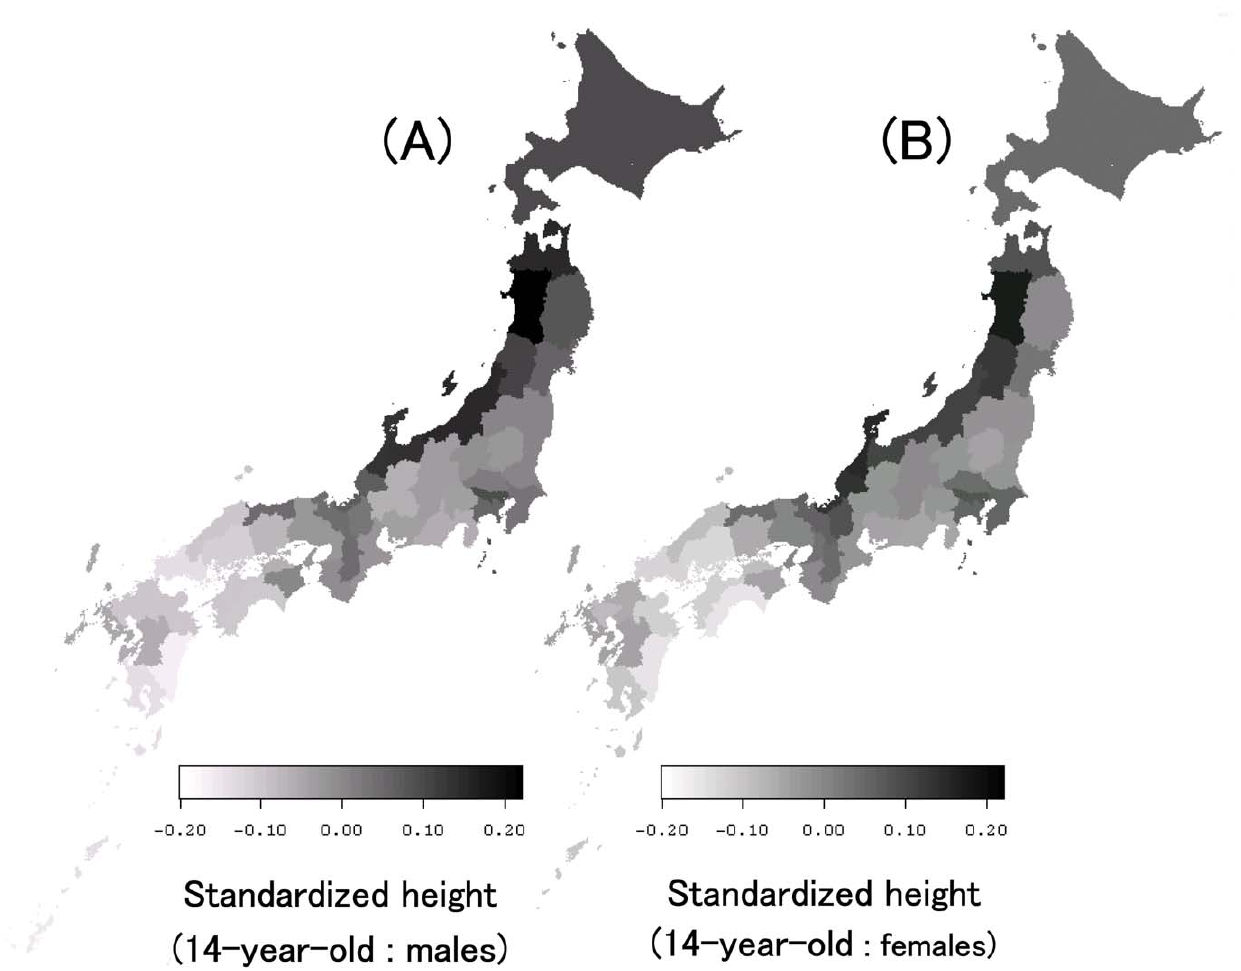
Figure 2. Distribution map of standardized height of Japanese youth. Distribution map of 13-year (1996 to 2008) average of the standardized height of (A) 14-year-old males and (B) 14-year-old females in each prefecture. The body height of Japanese youth tends to be larger in northern prefectures.